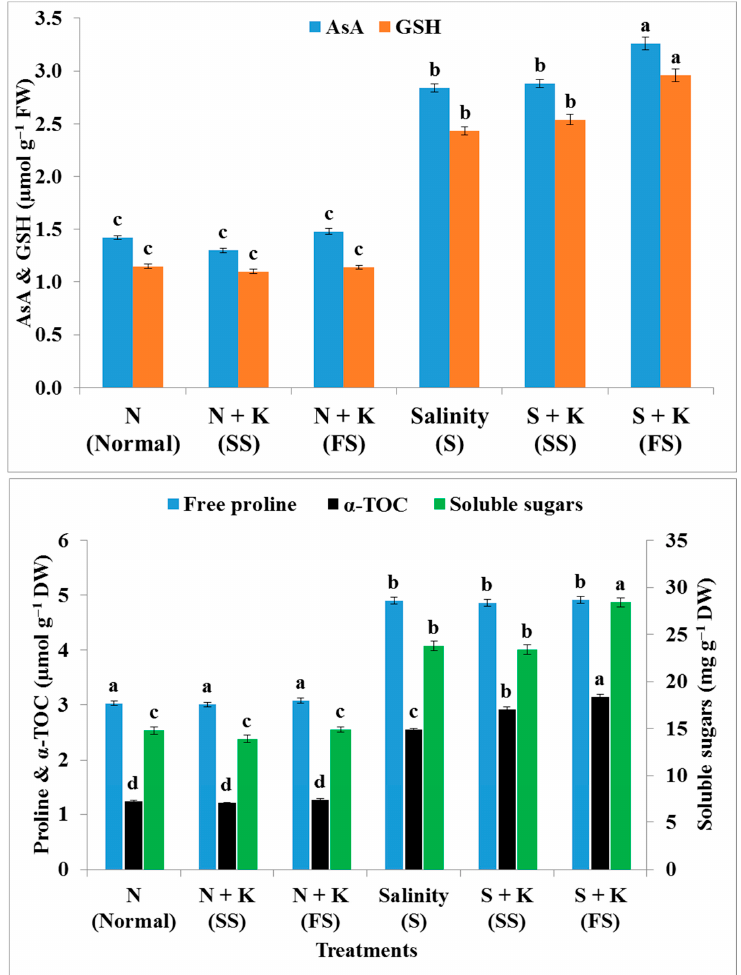
Figure 4. Effect of seed soaking (SS) and foliar spray (FS) of potassium (6 mM K 2 SO 4 ) on free proline, total soluble sugars, ascorbic acid (AsA), glutathione (GSH) and α -tocopherol ( α -TOC) contents of soybean plants grown under normal (EC = 2.68 dS m − 1 ) and salt stress (EC = 7.46 dS m − 1 ) conditions. Means followed by the same letter in each parameter are not significantly different according to the LSD test ( p ≤ 0.05). Error bars are ± Standard Error (SE).